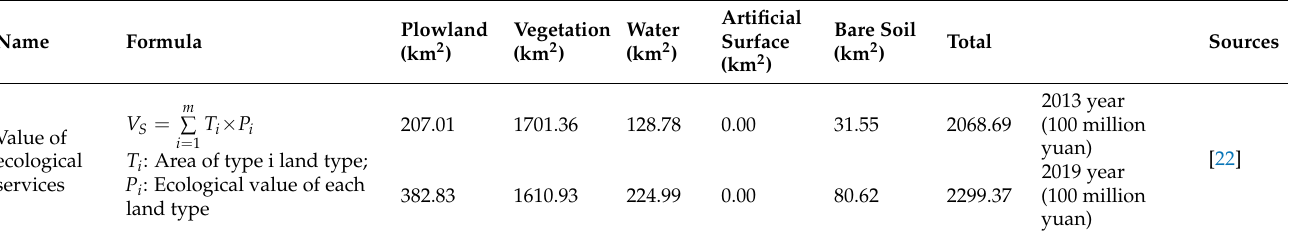
Table 6. Ecological service value of